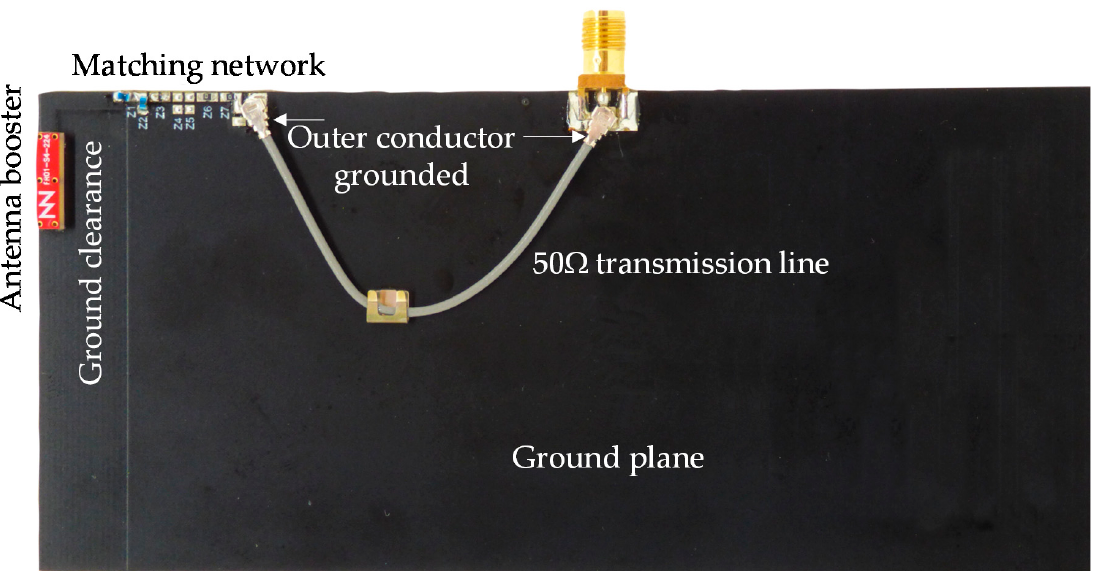
Figure 4. The 12 mm × 3 mm × 2.4 mm antenna booster on a 120 mm × 60 mm ground plane and the matching network with two components: series Z 1 = 33 nH and shunt Z 2 = 16 nH (Figure 2).